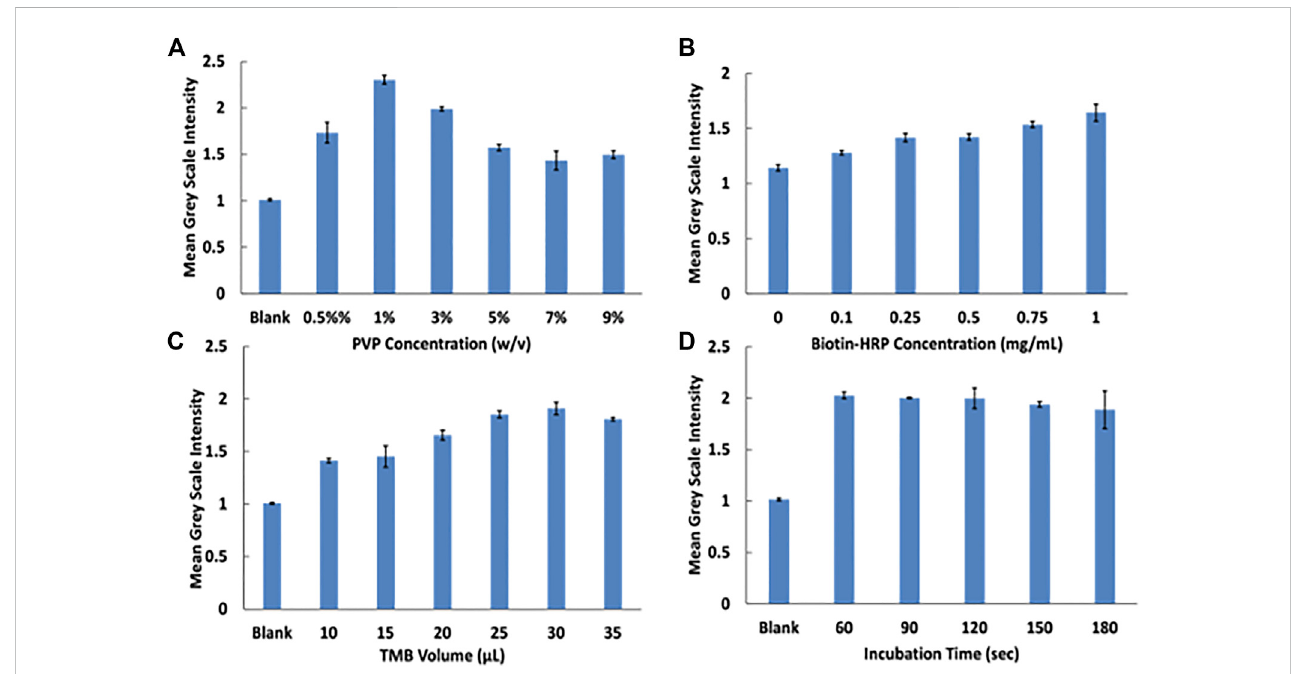
FIGURE 4 Assay optimization experiments. (A) PVP optimization at varying concentrations. (B) Biotin-HRP concentration optimization. (C) TMB volume optimization. (D) Magnetie beads with biotin-HRP incubation time.